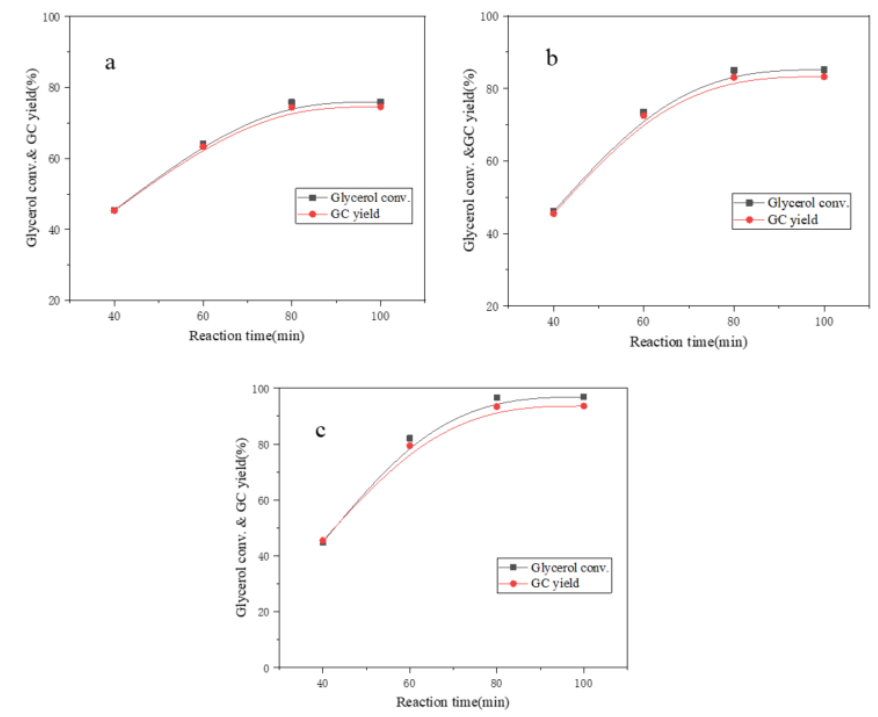
Figure 4. Glycerol conversion and GC yield catalyzed by β– CD – Zn ( a ) , β– CD – Ni ( b ) and β– CD – Ca ( c ).